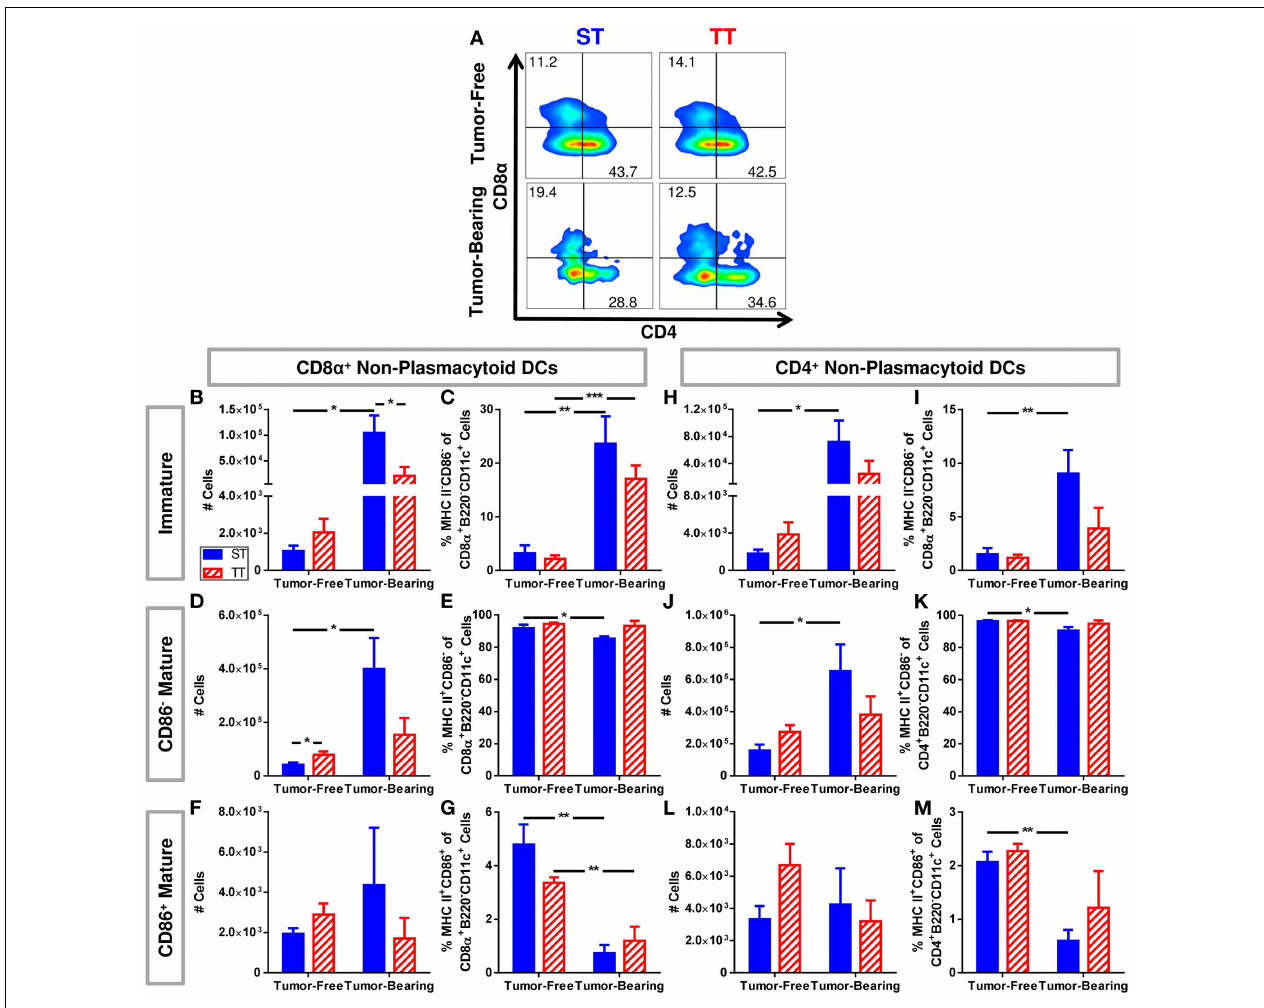
of CD8 α + MHC II + CD86 + B220 − CD11c + cells calculated from the total number of non-plasmacytoid cells. (G) The percentage of MHC II + CD86 + cells of the total population of CD8 α + non-plasmacytoid cells. (H–M) Quantification of data describing CD4 + non-plasmacytoid DCs. (H) The absolute number of CD4 + MHC II − CD86 − B220 − CD11c + cells calculated from the total number of non-plasmacytoid cells. (I) The percentage of MHC II − CD86 − cells of the total population of CD4 + non-plasmacytoid cells. (J) The absolute number of CD4 + MHC II + CD86 − B220 − CD11c + cells calculated from the total number of non-plasmacytoid cells. (K) The percentage of MHC II + CD86 − cells of the total population of CD4 + non-plasmacytoid cells. (L) The absolute number of CD4 + MHC II + CD86 + B220 − CD11c + cells calculated from the total number of non-plasmacytoid cells. (M) The percentage of MHC II + CD86 + cells of the total population of CD4 + non-plasmacytoid cells. Data presented as mean ± SEM; n = 5/group; Student’s t -test; * p < 0.05, ** p < 0.01, *** p <